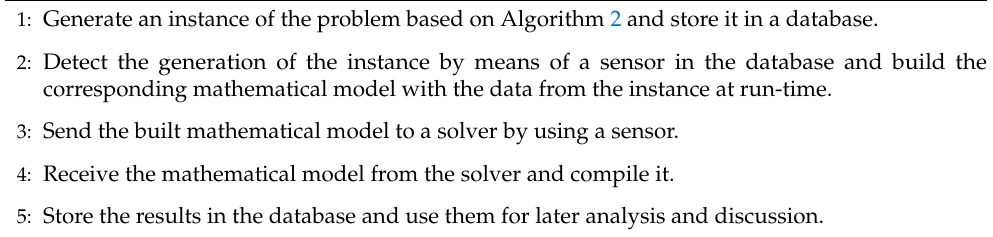
Algorithm 3 Approach for solving instances of the location problem for healthcare centers using a database-sensor.